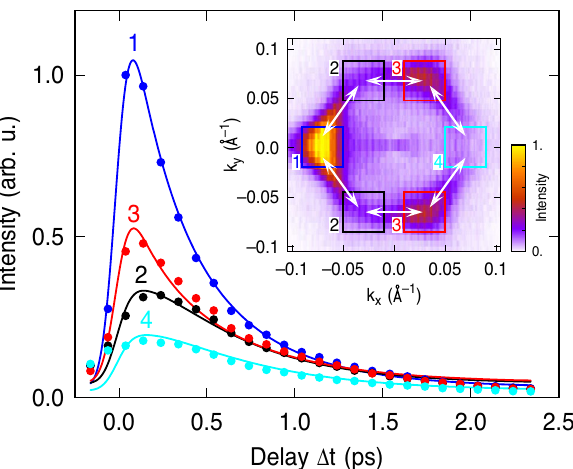
Figure 2. Time-evolution of the 2PPE intensity at different points of the k x – k y maps (c.f. Fig. 1l–o) as is indicated by the square integration areas in the inset (data points). The solid lines show fits of a rate-equation model for the population of the Dirac cone at these points considering inelastic electron scattering to lower energies and elastic scattering between adjacent areas as indicated by the white arrows in the